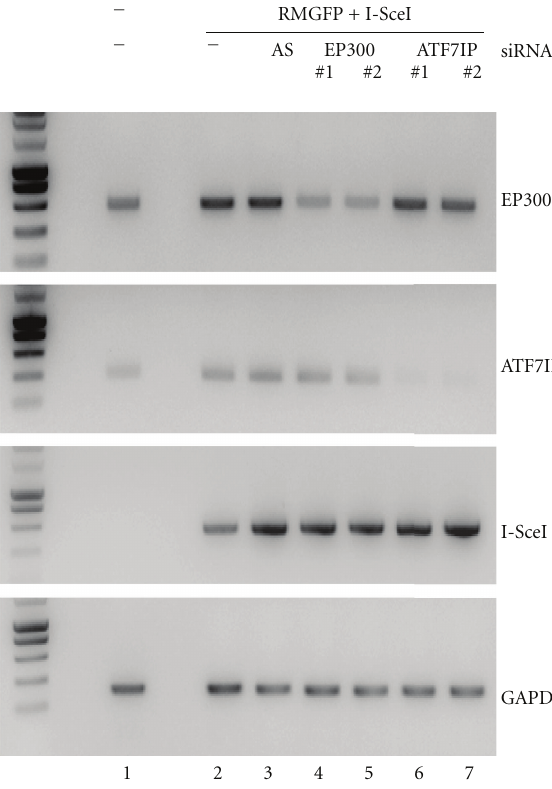
Figure 5: Characterization of EP300 and ATF7IP knockdown. Total RNA was extracted 48 hours after transfection with the indicated DNAs and siRNAs (two di ff erent siRNA sequences were used to target each of the ATF7IP and EP300 genes). RT-PCR was carried out to amplify mRNA transcribed from the ATF7IP , EP300 , GAPDH , and I-SceI genes. The e ff ects of siRNAs on their targets were monitored by analyzing band intensity after electrophoresis in 1% agarose gels. Lane 1, untransfected cells. In lanes 2 to 7, the cells were transfected with the plasmid carrying the repair matrix and the I-SceI expression cassette. Lane 2, no siRNA; lane 3, AS siRNA; lanes 4 and 5, siRNA against EP300; lanes 6 and 7, siRNA against ATF7IP.